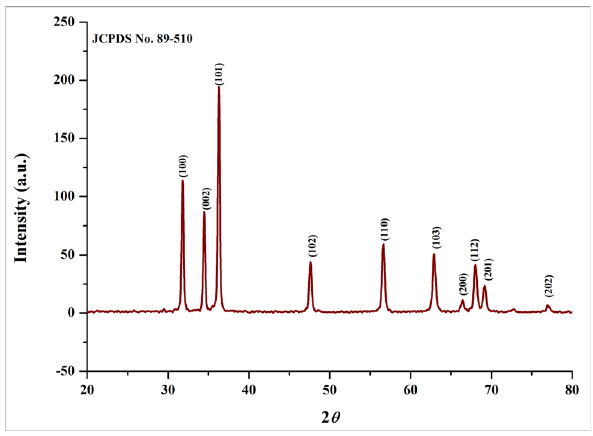
Figure 2: XRD pro fi le of phyto - fabricated ZnO NPs from S. acuta .